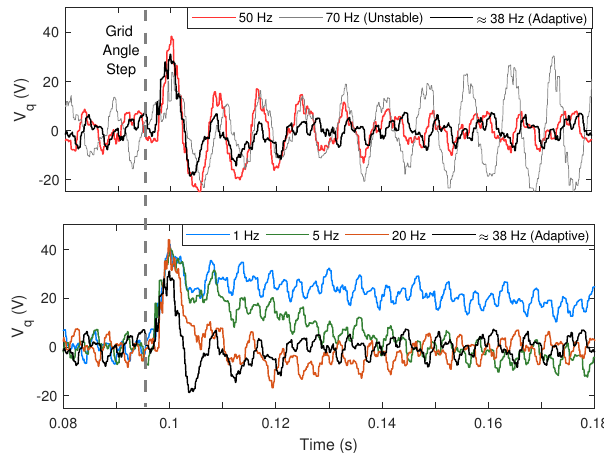
Figure 14. Performance comparison of different PLLs during phase jump in grid